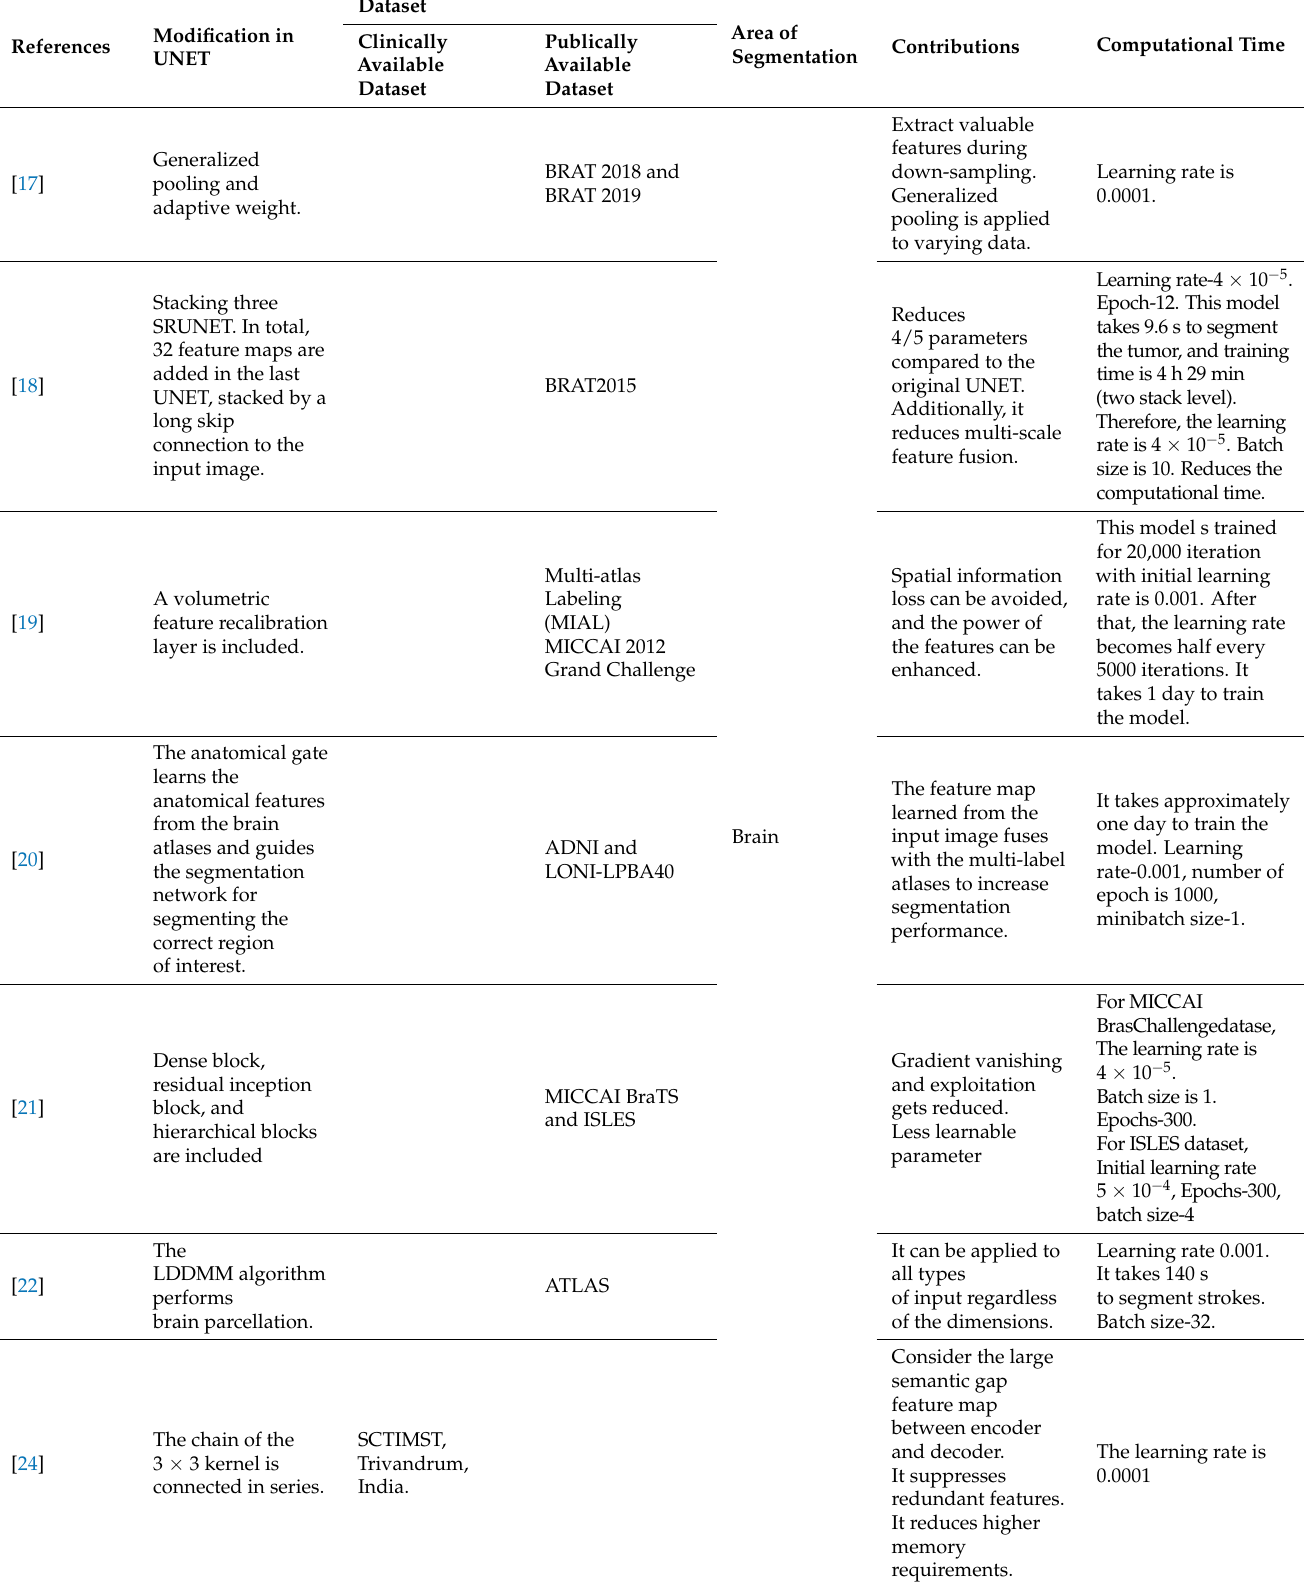
Table 2. Summary of